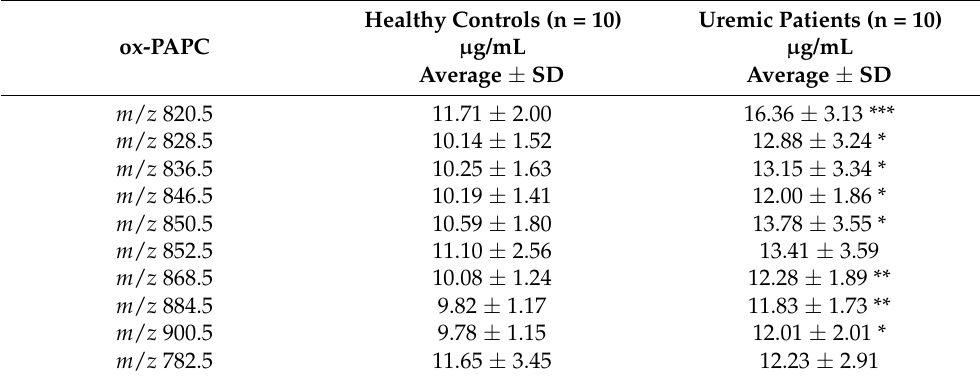
Table 1. Long-chain ox-PAPC product concentrations in VLDL of healthy controls and uremic patients.